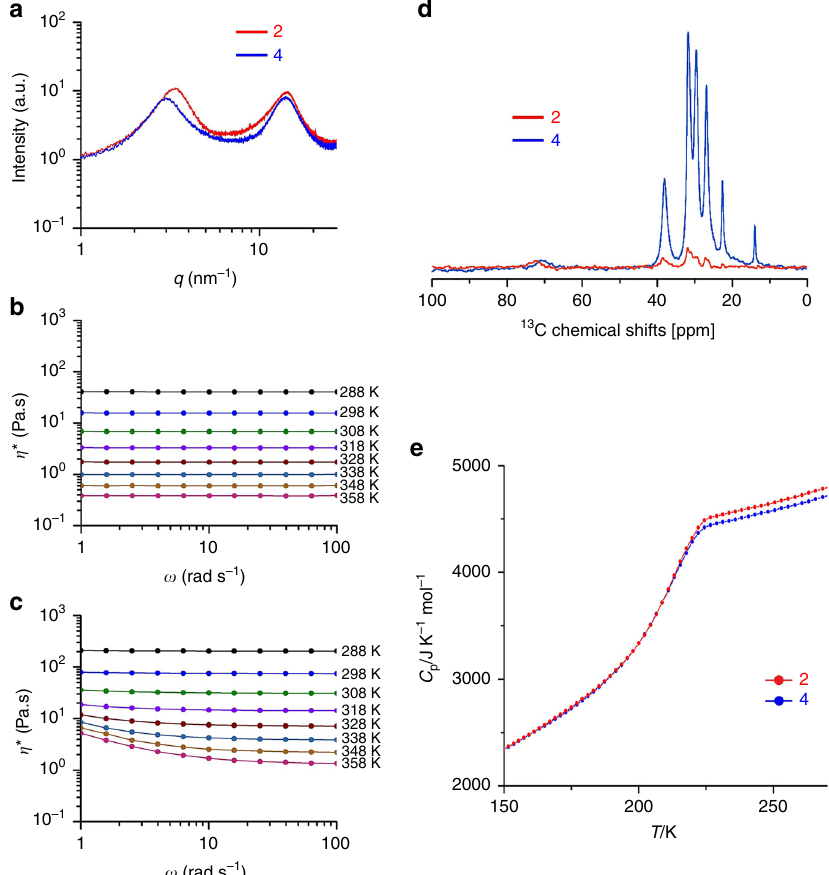
Fig. 2 Impact of the positions of alkyl substituents on the liquid physical properties. a , SWAXS pro fi les of compounds 2 and 4 at 296 K. b , c Change of complex viscosity ( η *) of compounds 2 ( b ) and 4 ( c ) as a function of angular frequency ω at various temperatures ranging from 288 to 358 K. d Comparison of magic-angle spinning (MAS) 13 C NMR spectra of compounds 2 and 4 in cross-polarisation (CP)-MAS mode, which was collected in the solvent-free liquid-state under MAS of 12.5 kHz at 296 K. e Heat capacity ( C p ) measurements by using a custom-made calorimeter under adiabatic